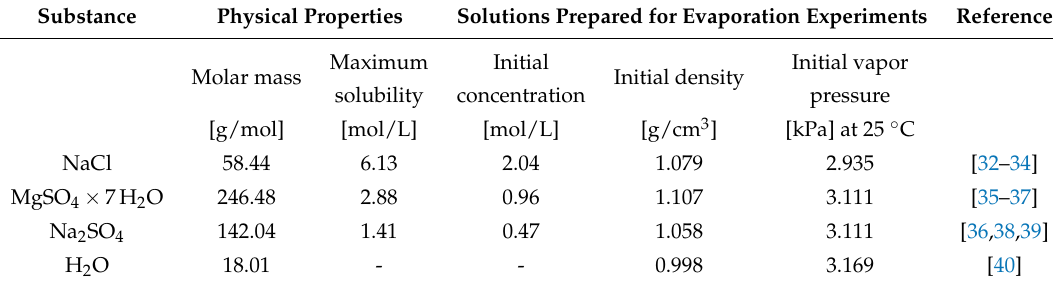
Table 1. Properties of the saline solutions at 20 ◦ C. The density of the solutions and the vapor pressures are interpolated from the listed references in the last column. The vapor pressure of H 2 O corresponds to fully saturated wet